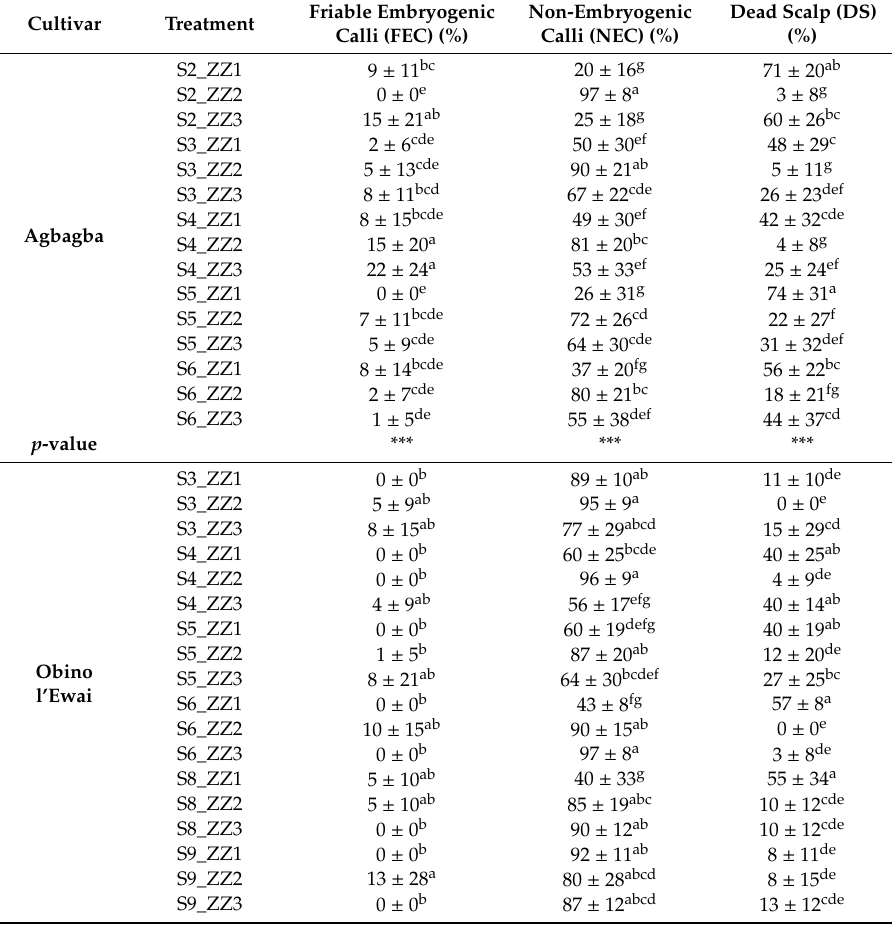
Table 2. E ffi ciency of embryogenic callus development from scalps of West African plantain cultivars, Agbagba, Obino l’Ewai, and Orishele, on di ff erent treatments. Cultivar